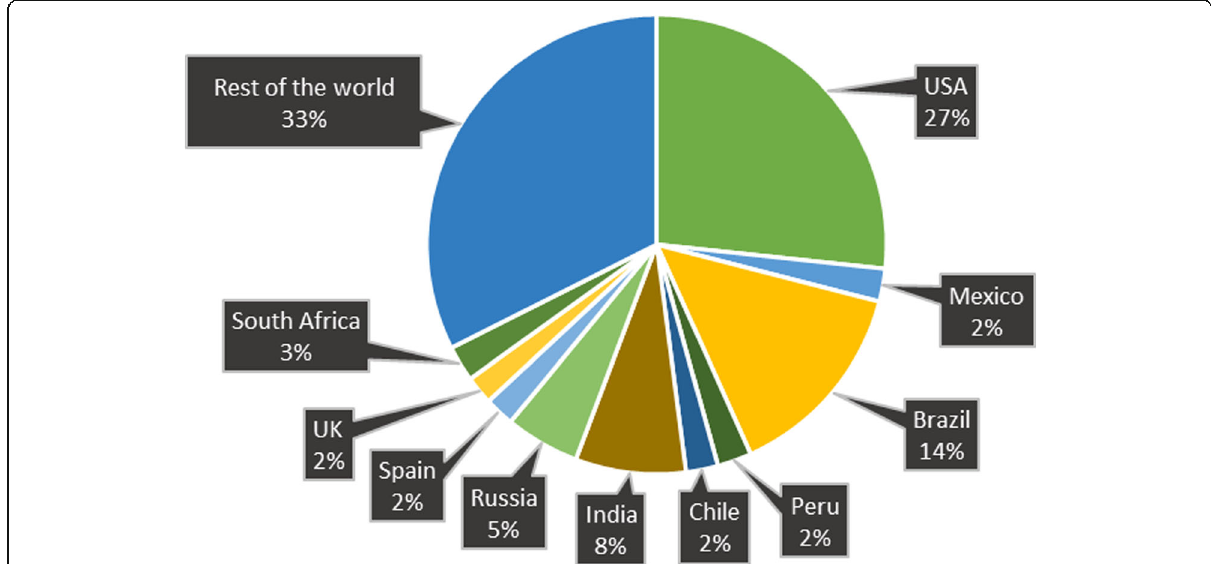
Fig. 2 Global distribution of confirmed cases of the COVID-19